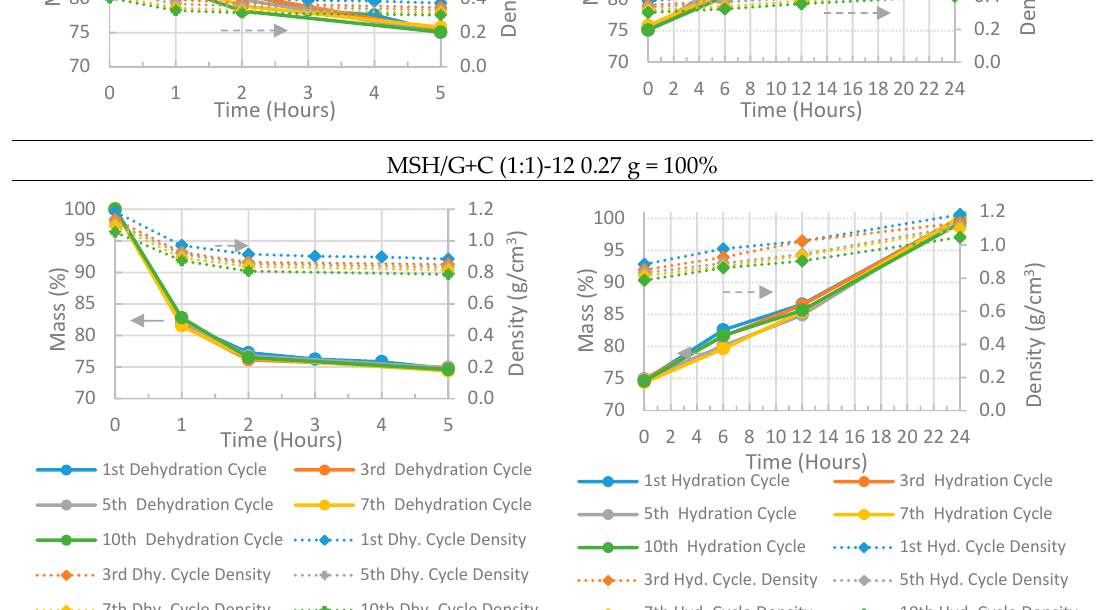
Figure 12. Hydration and dehydration charts of pellets prepared under a 0.77 kN ⋅ mm − 2 compression ratio. Each pellet has a 75% salt hydrate mass ratio. Left column: dehydration charts; right column: hydration charts. All the mass measurements have an accuracy of ± 0.001 g (< 0.5%).